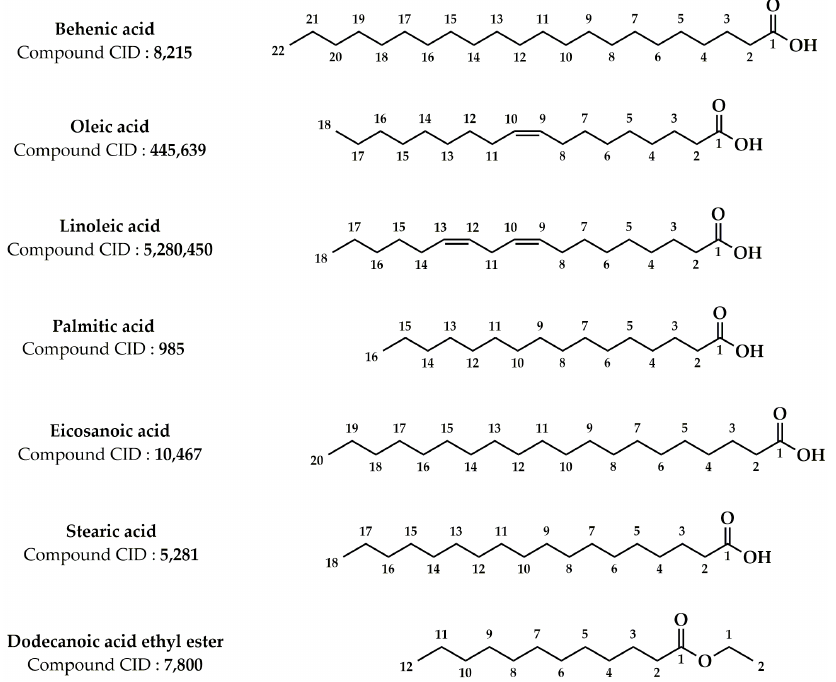
Figure 5. Chemical structures of the fa tt y acids identi fi ed in Z. lotus .